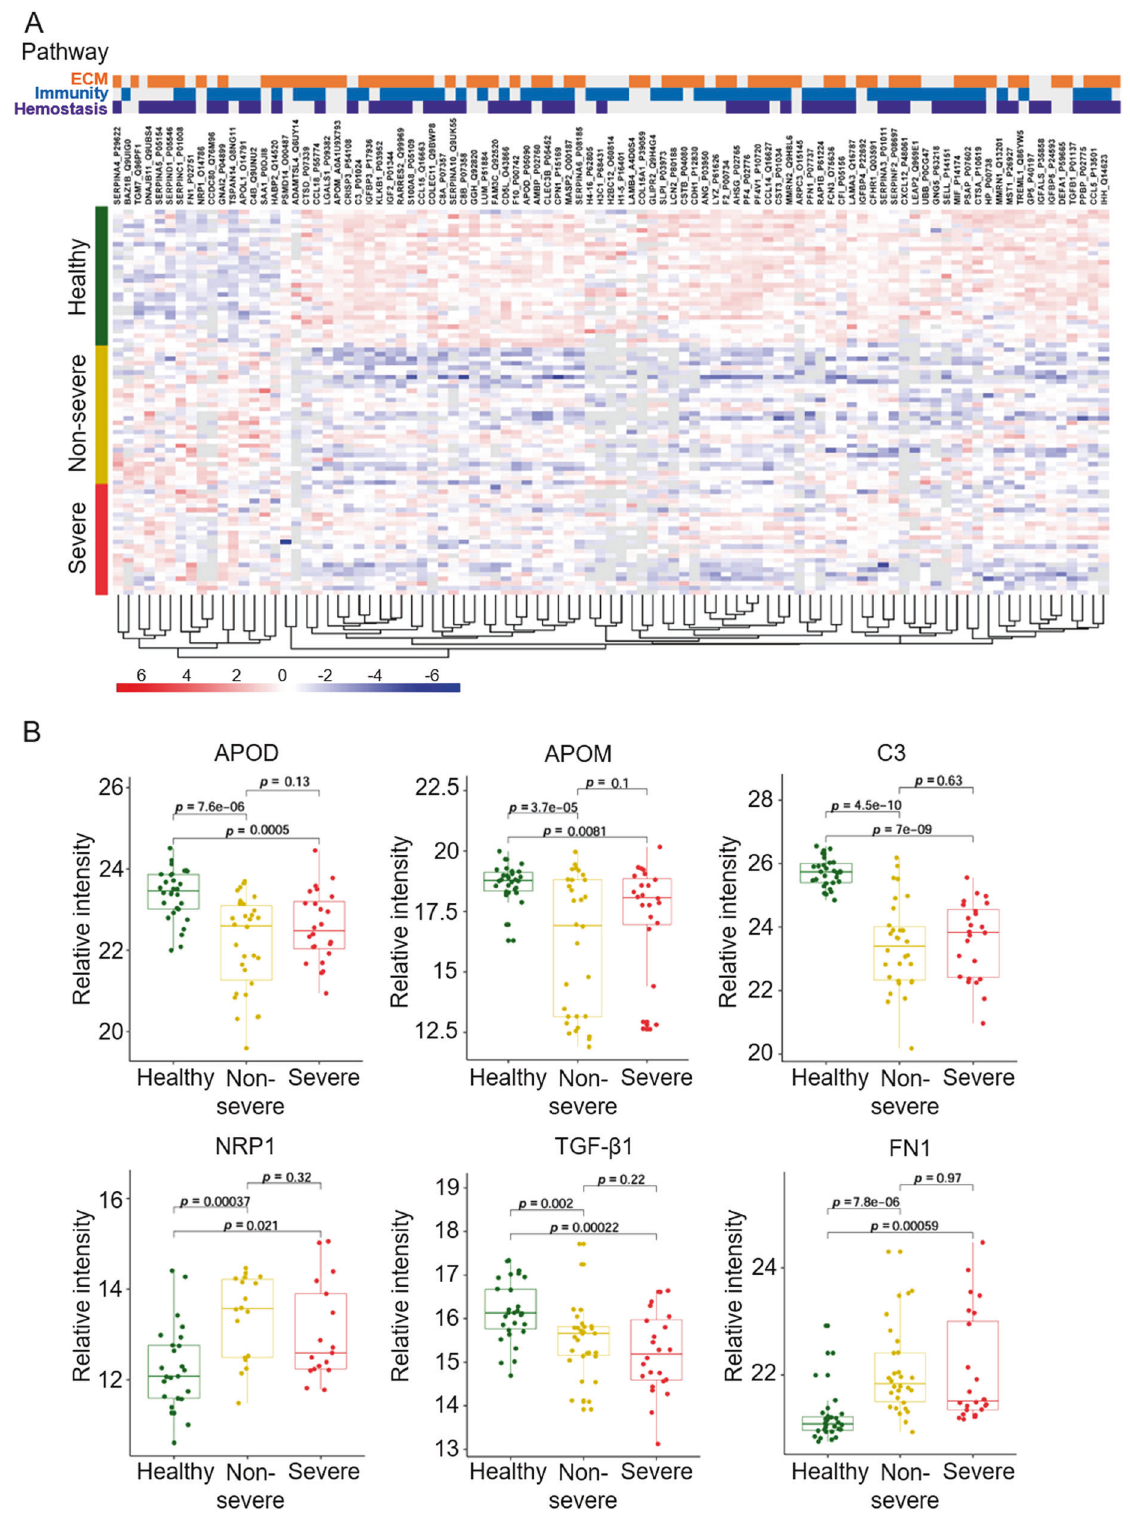
Fig. 2 Proteomic pro fi ling of plasma samples obtained from COVID-19 survivors 6 months after discharge and healthy control subjects. A Heatmap visualization of signi fi cantly differentially expressed proteins (DEPs) whose regulation concentrated on three enriched pathways. The graphs show the relative intensity of DEPs. Proteins included in the heatmap meet the requirement that fold-change >1.5 or <0.67 and p value ( t test) of <0.05. p values were then adjusted using the Benjamini-Hochberg correction (false discovery rate, <0.05). The color bar represents the relative intensity of identi fi ed proteins from − 6 to 6. B The boxplots show six proteins, which are signi fi cantly different between COVID-19 survivors 6 months after discharge and healthy control subjects. Healthy group, n = 30; non-severe group, n = 30; severe group, n = 24. APOD apolipoprotein D; APOM apolipoprotein M; C3 complement 3; FN1 fi bronectin 1; NRP1 Neuropilin-1; TGF β 1 transforming growth factor beta 1.